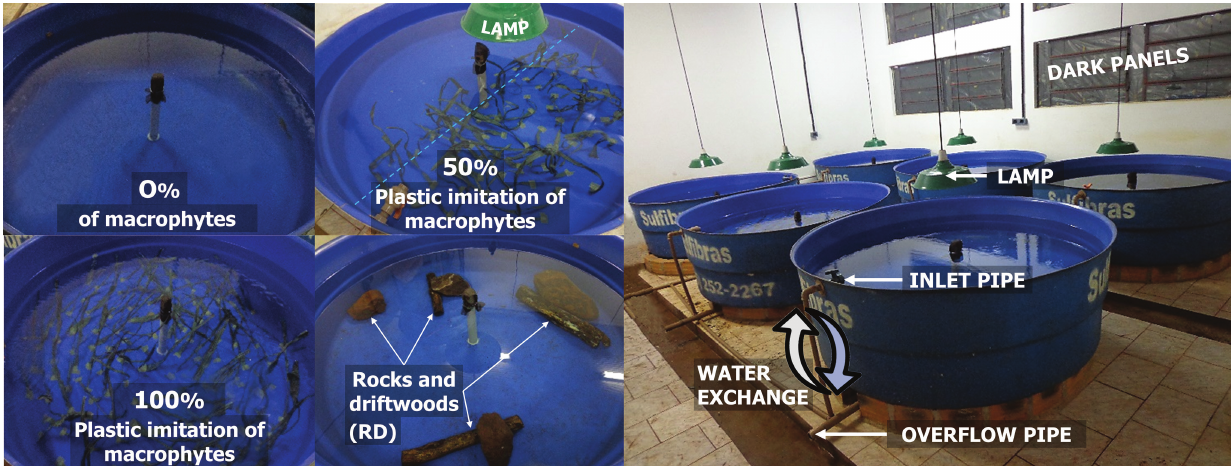
Fig. 1 . Experimental tanks used. The left side of the image shows the simulation of habitat complexity using a plastic imitation of macrophytes: upper left – 0% habitat complexity, upper right – 50%, bottom left – 100% and bottom right – RD (rocks and driftwood). The right side of the image shows the individual water circulation system, the lamps used to manipulate the photoperiod of 12:12 h light:dark and the dark panels at the windows to avoid the influence of natural